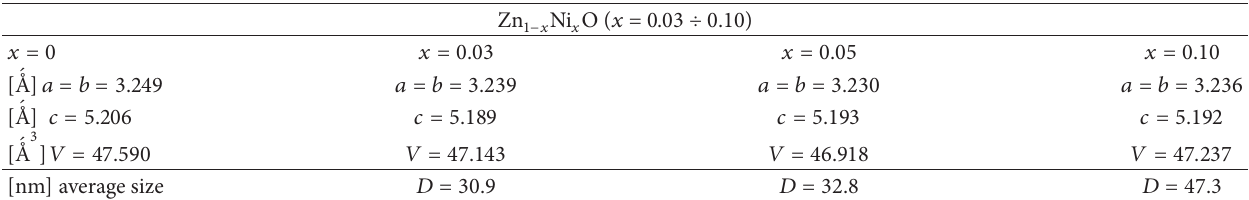
Table 1: Lattice parameters calculated from the XRD data of Zn 1−𝑥 Ni 𝑥 O ( 𝑥 = 0.03 ÷ 0.10 ) and mean crystalline size (with Debye-Scherrer formula [18]).